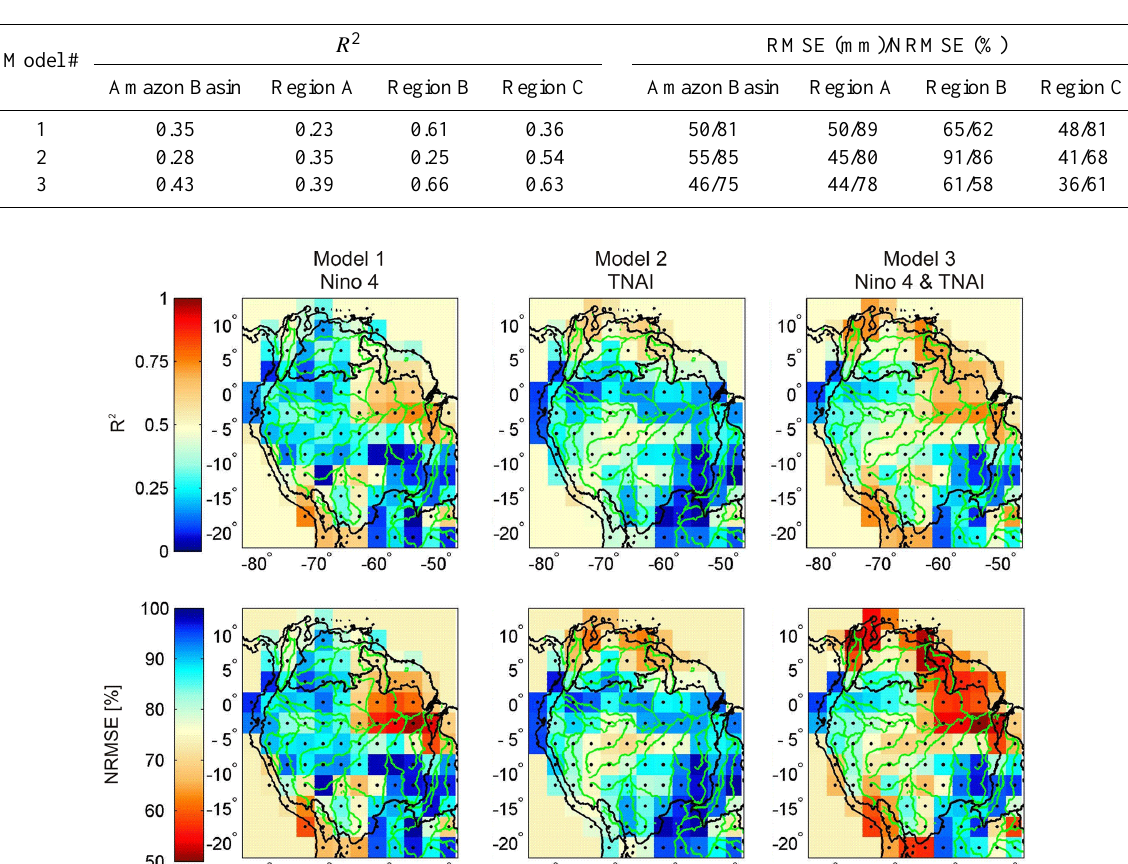
Figure 3. Coefficient of determination ( R 2 ) and normalized root mean square error (NRMSE) for the three models described in Table 1 and computed for the period from August 2002 through July 2012. The RMSE was normalized at each location using the standard deviation of GRACE interannual terrestrial water storage anomalies shown in Fig. 1b. The prescribed minimum lead time for the three models was 3months. Cells where the linear fit was significant ( p < 0 . 05) are marked with a black